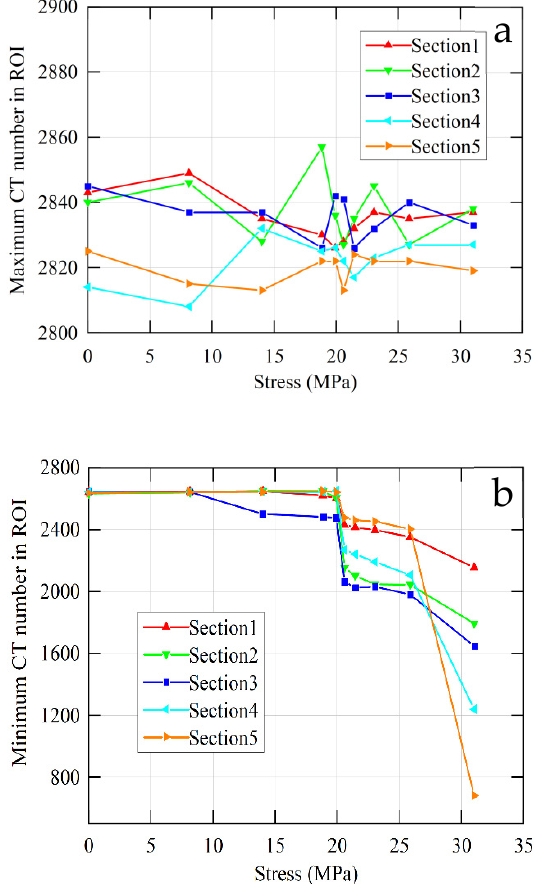
Figure 7. The curves of the maximum CT numbers of the five cross-sections with the loading process: ( a ) the curves of the maximum values of CT number changing with stress in ROI; ( b ) the curves of the minimum values of CT number with stress in ROI.